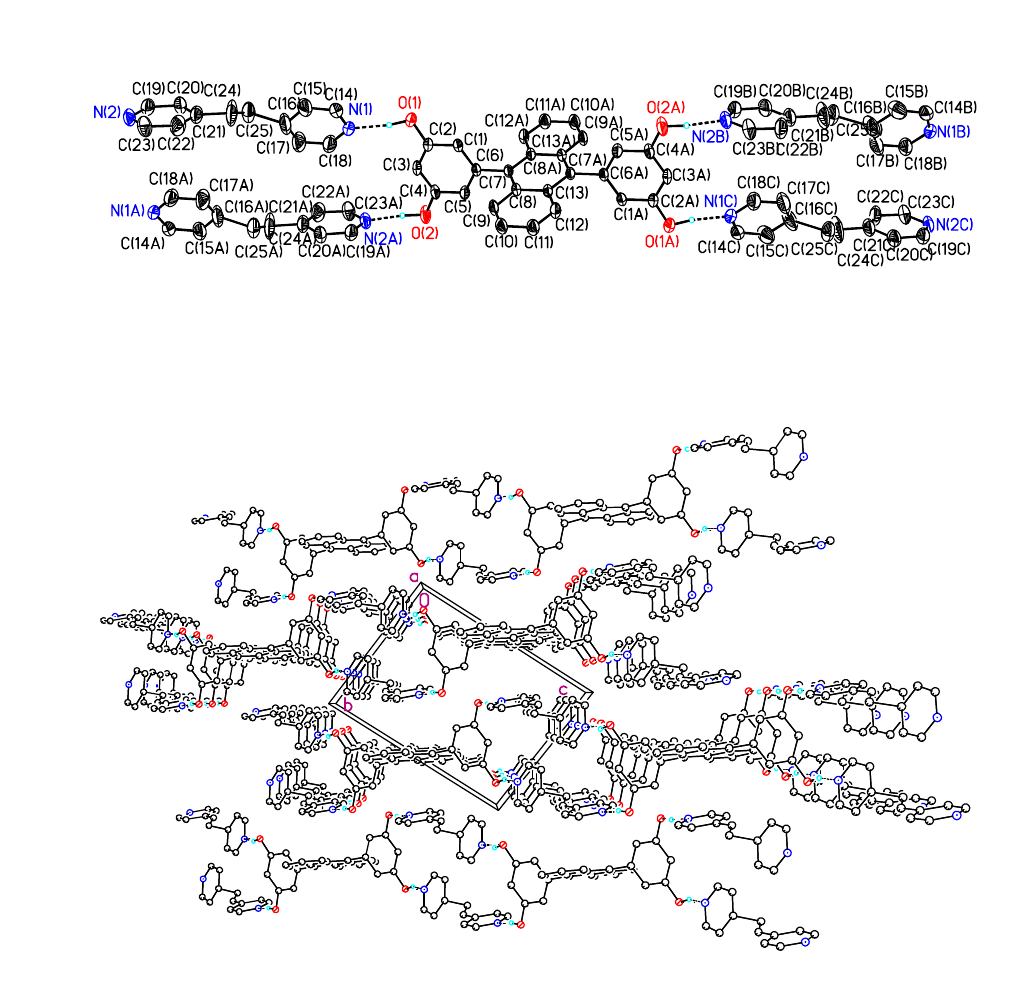
Figure 2 (a) The crystal structure of 2. Hydrogens were omitted for clarity. (b) The crystal-packing of 2 viewed down the a axis. Notice that 2 leads to infinitely rectangular macrocycles, with sizes ca . 14.575 Å × 4.809